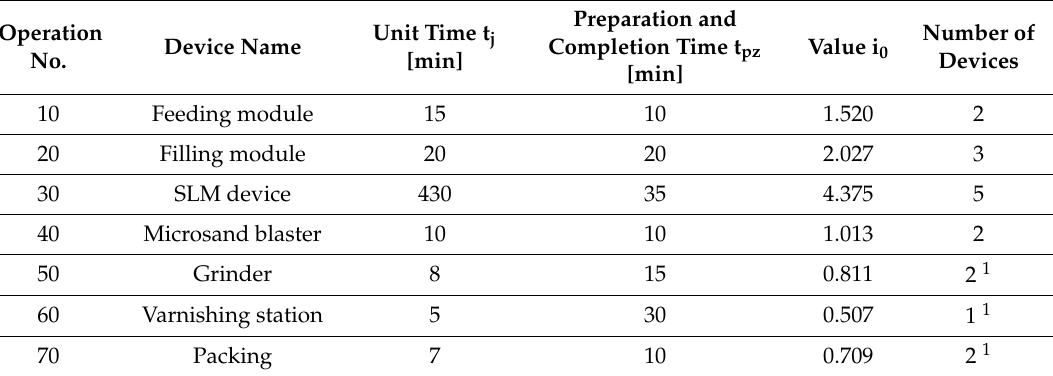
Table 2. Sequence of technological operations for product Y along with the calculated i 0 number of machines and devices necessary to implement the production